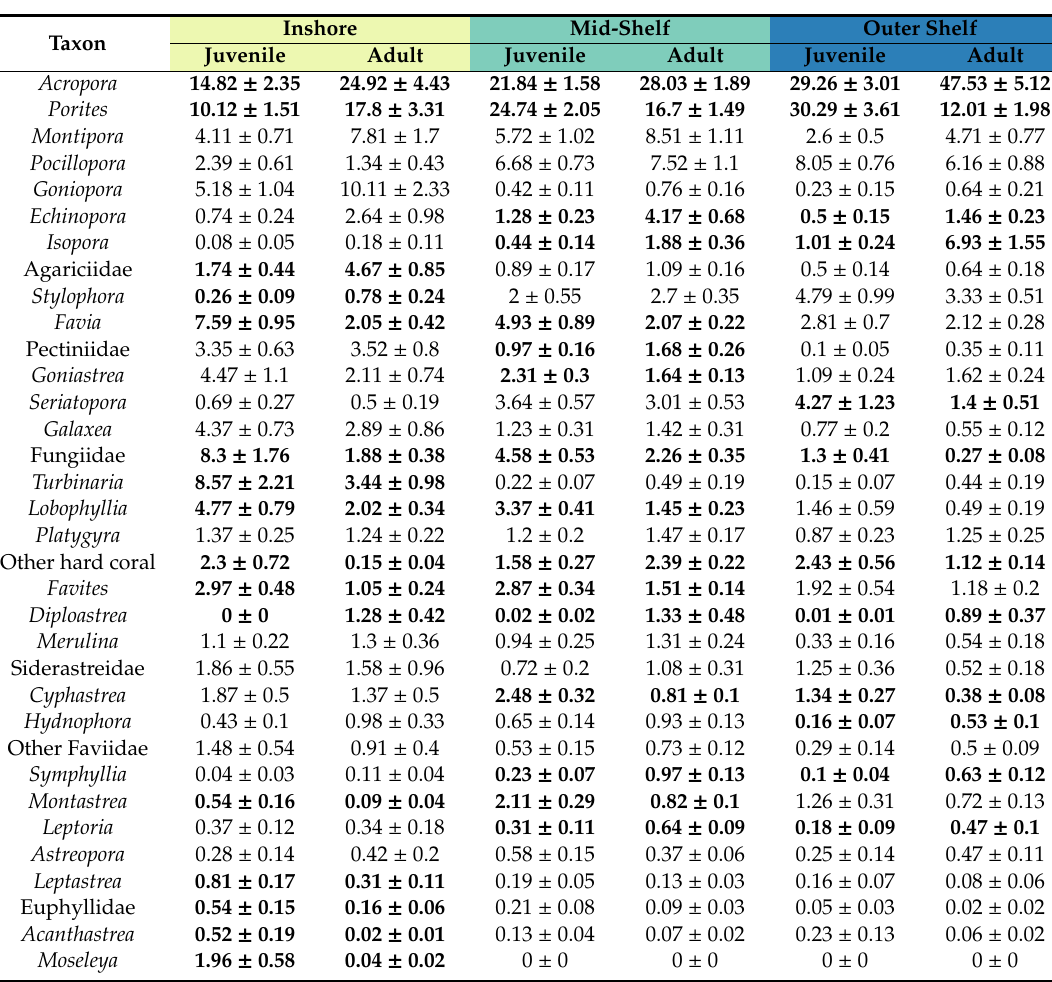
Table A1. Relative abundance of juvenile and adult coral taxa (mean ± se) for all reefs surveyed, by shelf position. Bold values represent which pairs of coral taxa that had significantly di ff erent population mean ranks ( p < 0.05) from nonparametric Wilcoxon paired